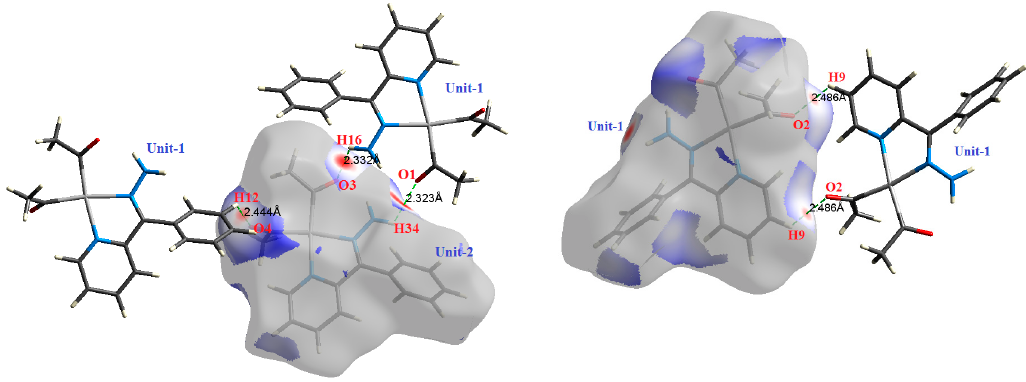
Figure 4. The most important intermolecular contacts in complex 2 .